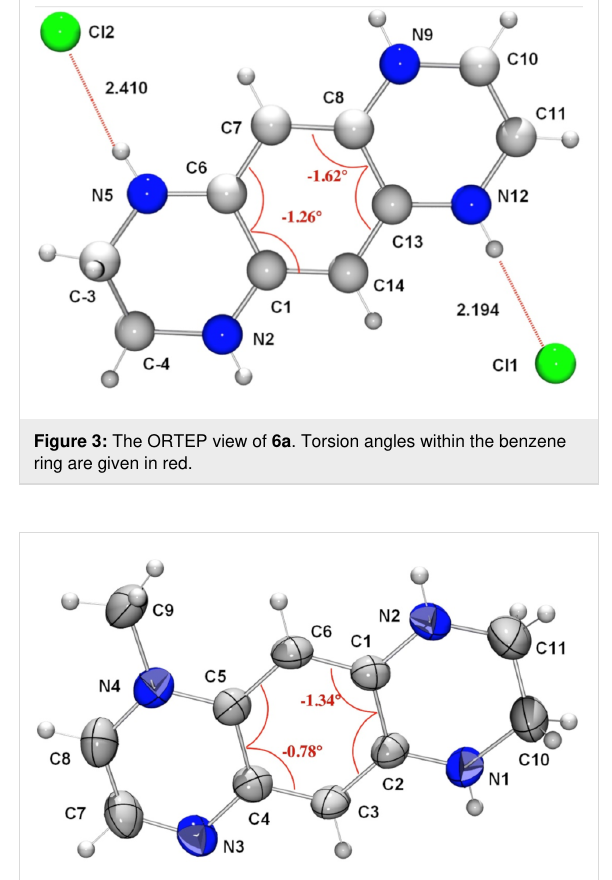
(Figure 3). At the same time, the geometry optimized structure of 6a exhibits much greater torsion angles of 6.23 and